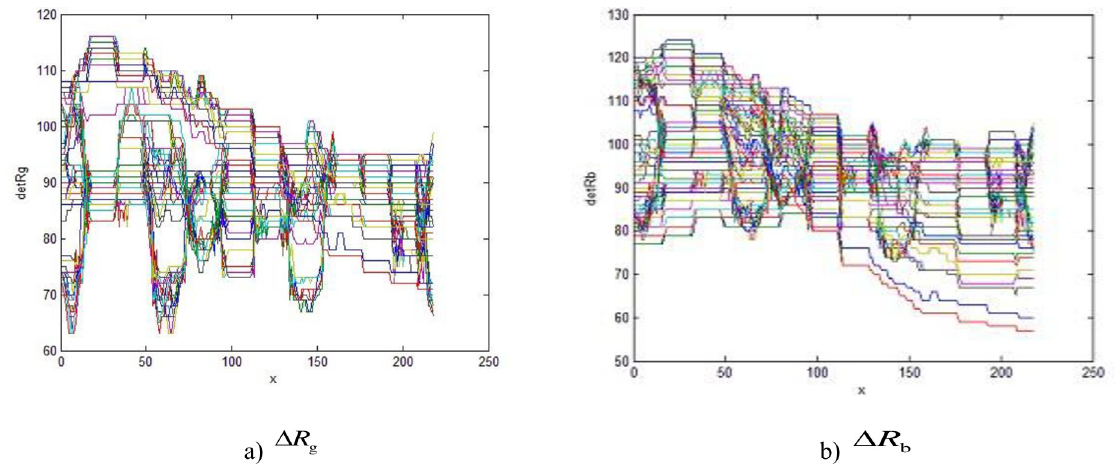
Fig 3. The red area distribution.